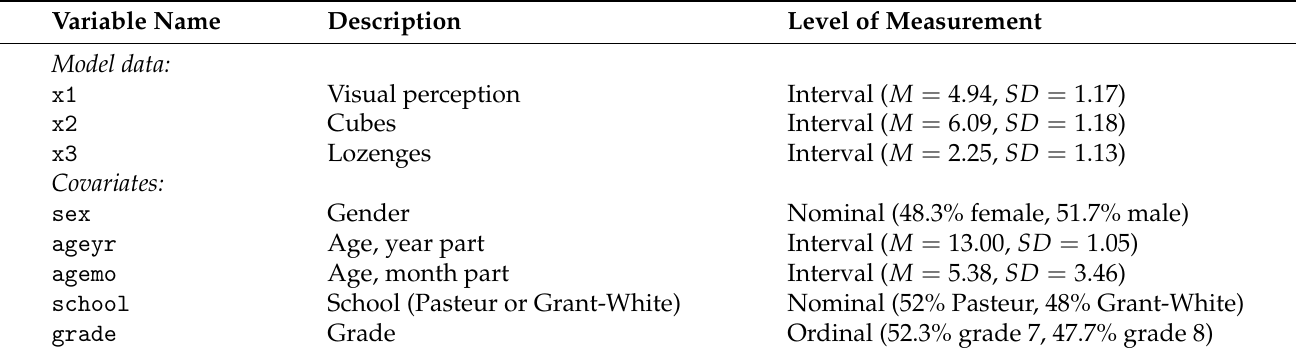
Table 1. Selected variables from the HolzingerSwineford1939 data